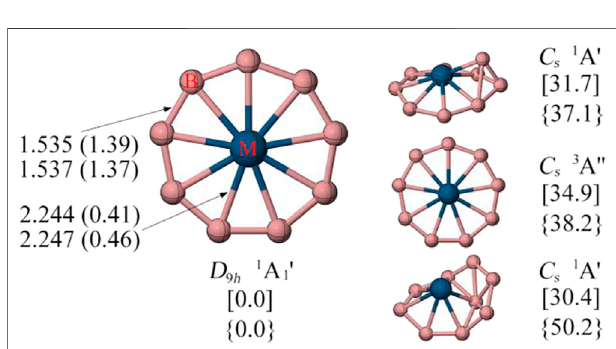
FIGURE 2 | The minimum energy geometries and the corresponding bonddistancesinÅandWBIvaluesinparenthesesofRuB 9 − (top) andOsB 9 − (bottom) are given at the PBE0/def2-TZVPP level. Relative energies in kcal/ mol of the low-lying energy isomers of [RuB 9 − ] and {OsB 9 − } are given at the CCSD(T)/def2-TZVPP//PBE0/def2-TZVPP level with ZPE correction of PBE0. The T1 diagnostic are less than 0.05.